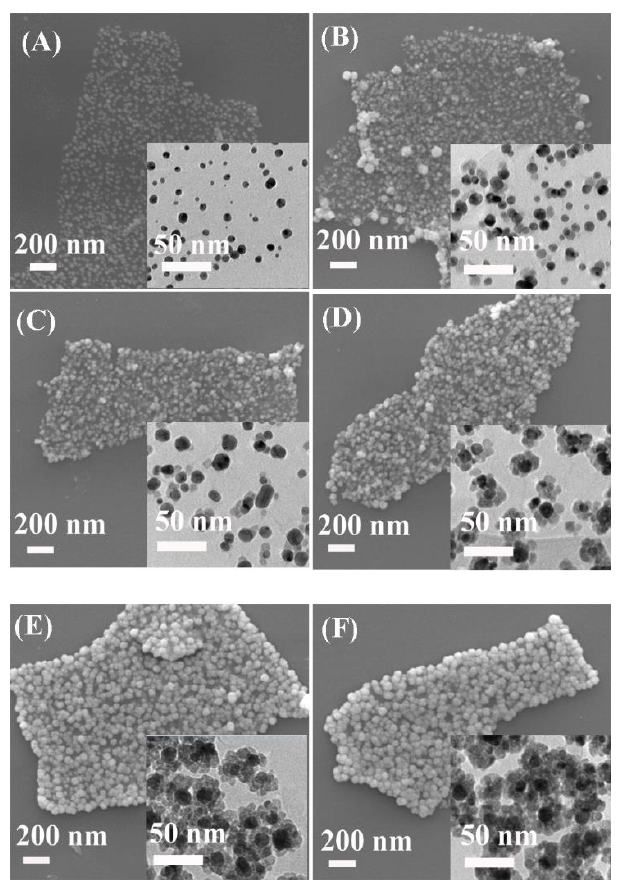
Figure 2. SEM images of ( A ) Ag-rGO and Ag@Cu 2 O-rGO nanocomposites with different concentrations of Cu(NO 3 ) 2 solution (( B – F ), S-2 mM, S-4 mM, S-6 mM, S-8 mM, and S-10 mM). The insets are the corresponding TEM images.